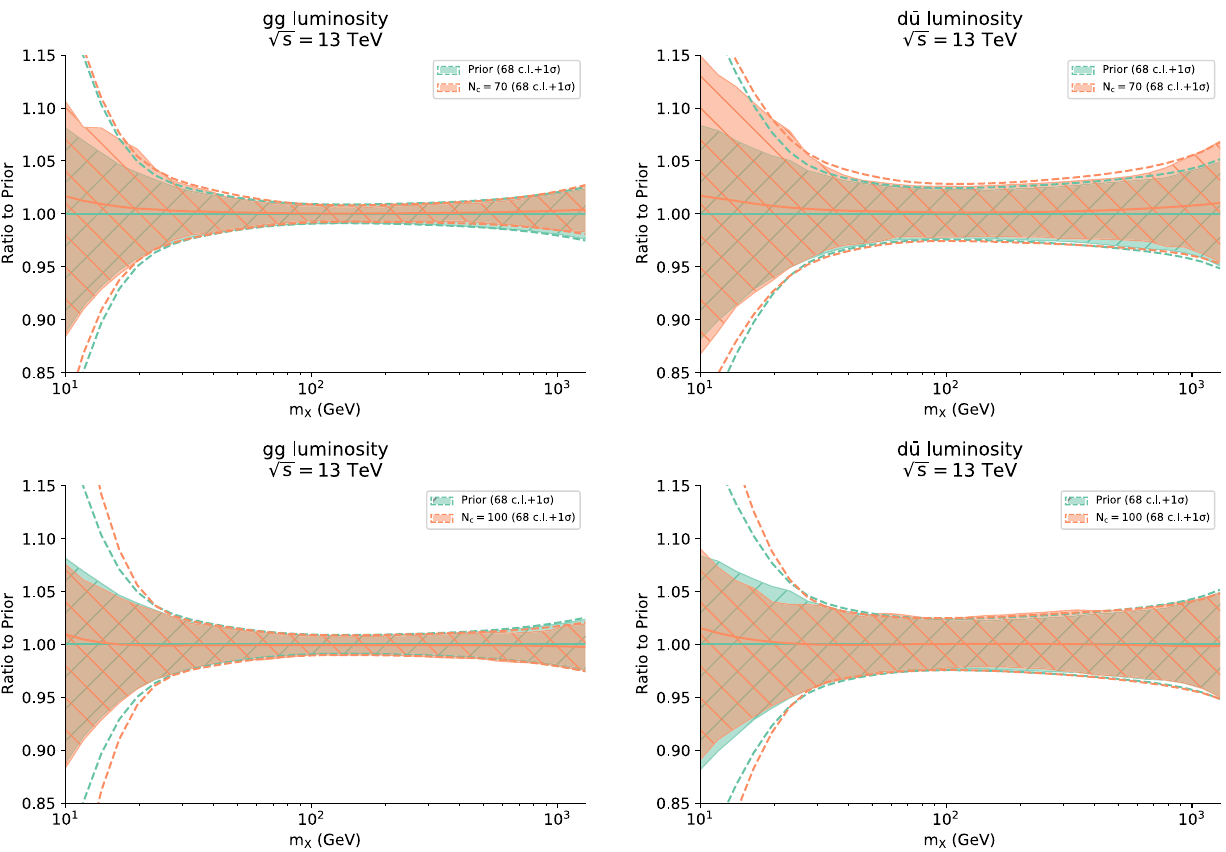
√ s = 13GeV. The results